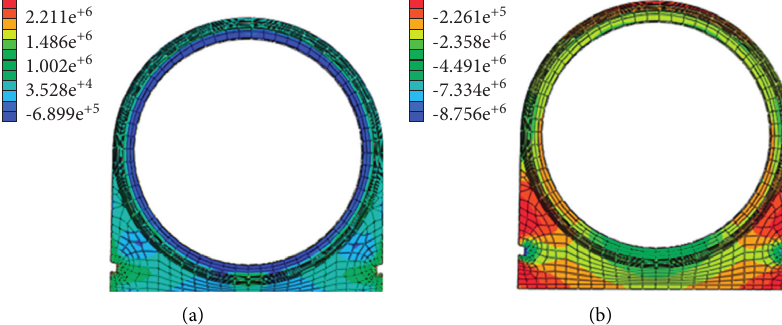
Figure 13: Stress cloud diagram of the prestressed culvert structure: (a) maximum principal stress; (b) minimum principal stress.